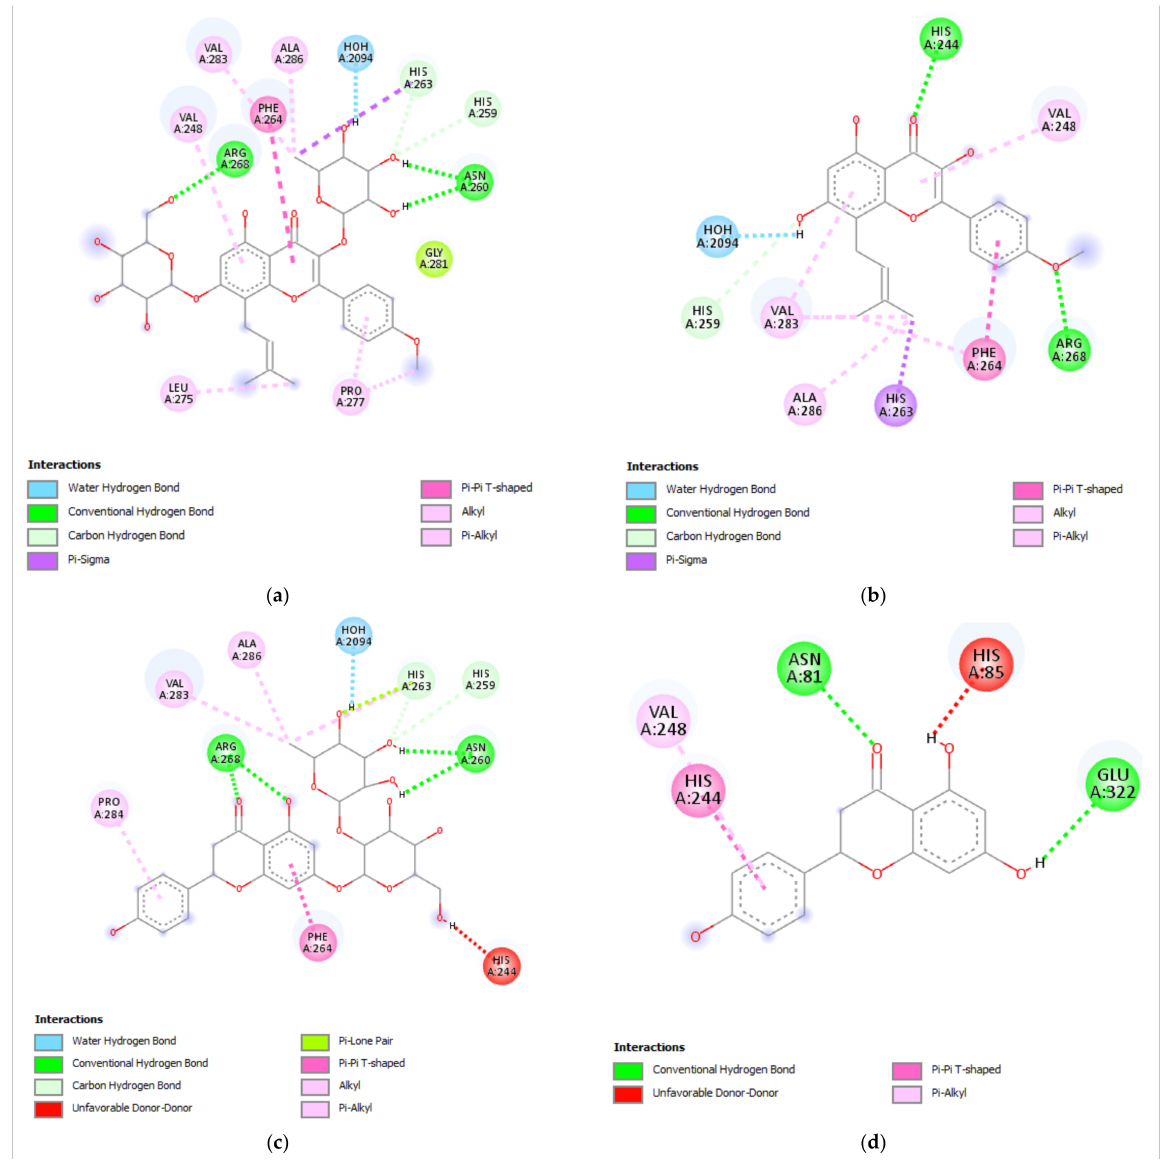
Figure 2. Interactions between ( a ) icariin, ( b ) icaritin, ( c ) naringin, and ( d ) naringenin molecules with Ab TYR residues. Ligands are shown as lines and tyrosinase residues as spheres. Interactions were rendered with Discovery Studio visualizer v21.1.0.20298 (BIOVIA, San Diego, CA, USA